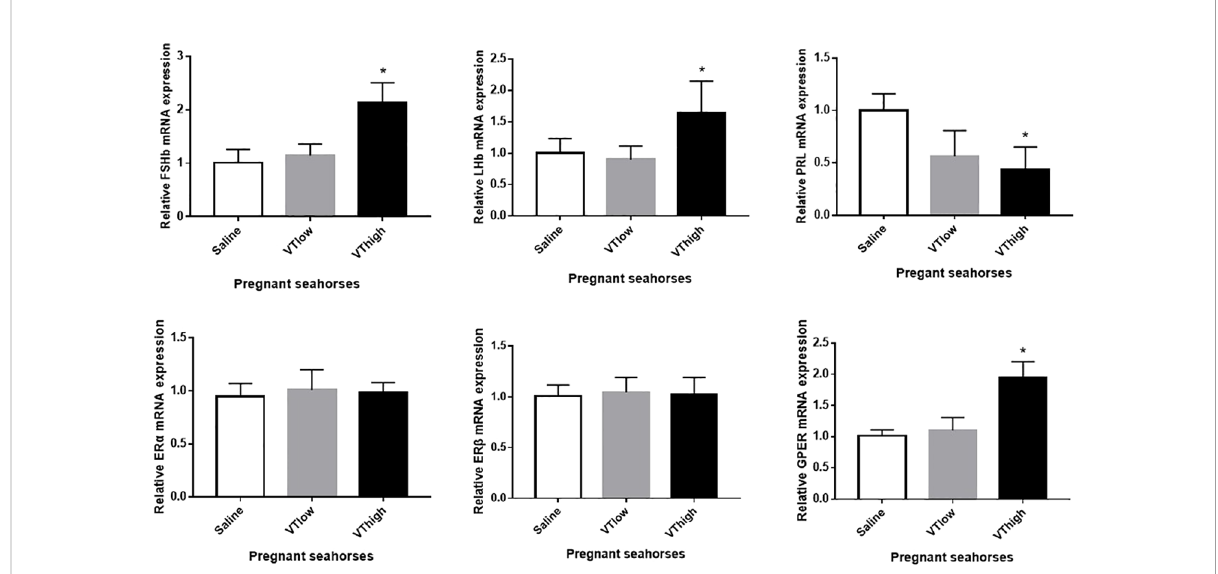
FIGURE 6 Effects of the VT core peptide injection on the expression of FSH b , LH b , and PRL genes in the pituitary and ER a , ER b , and GPER genes in the brood pouch of pregnant lined seahorses. The mRNA expression levels were determined using qRT-PCR. Data are presented as mean ± SEM. Asterisks indicate signi fi cant differences between different treatments ( p <